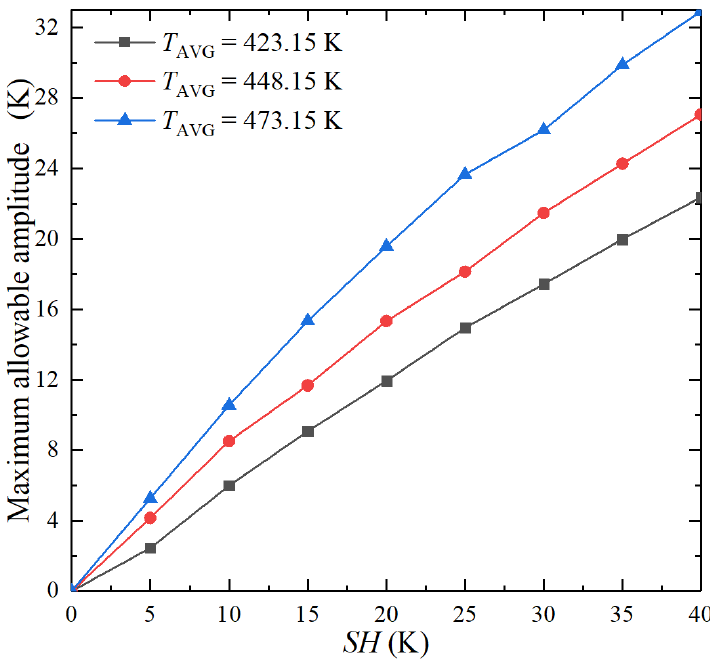
Figure 16. Maximum allowable amplitude with superheat degrees. Table 3. Operation parameters of the ORC system under different superheat degrees.